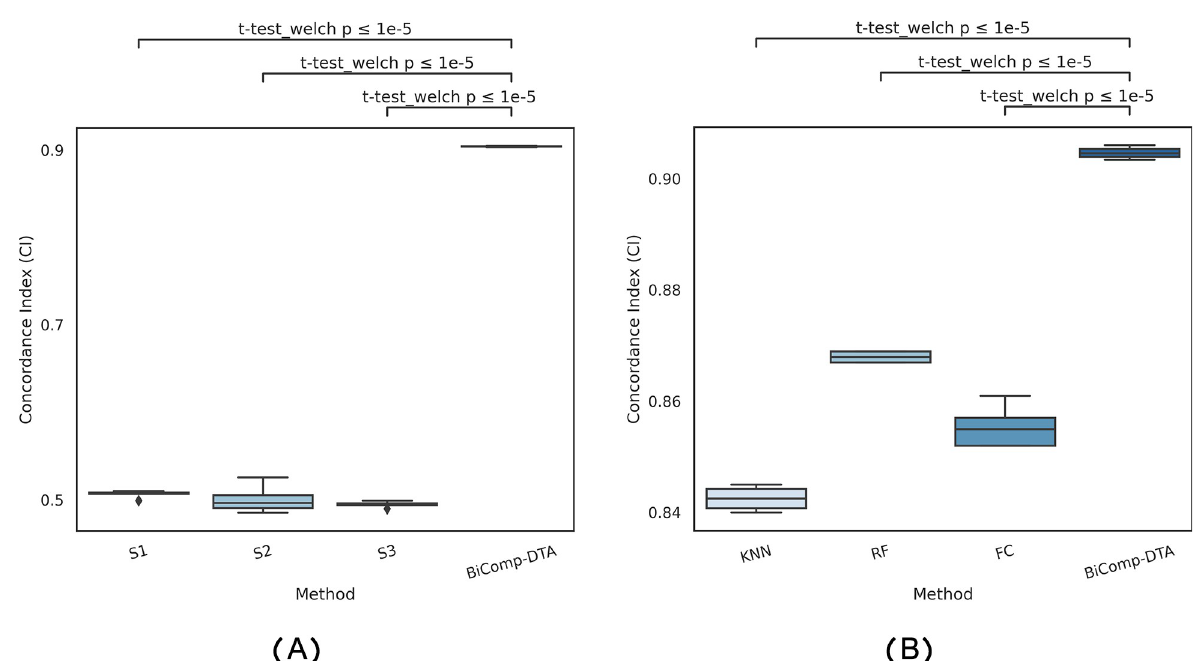
Fig 5. Full distribution of CI values and statistical test for the BiComp-DTA, compared to the (A) straw models S1, S2, S3, and (B) baseline models KNN, RF, and FC- Davis dataset.